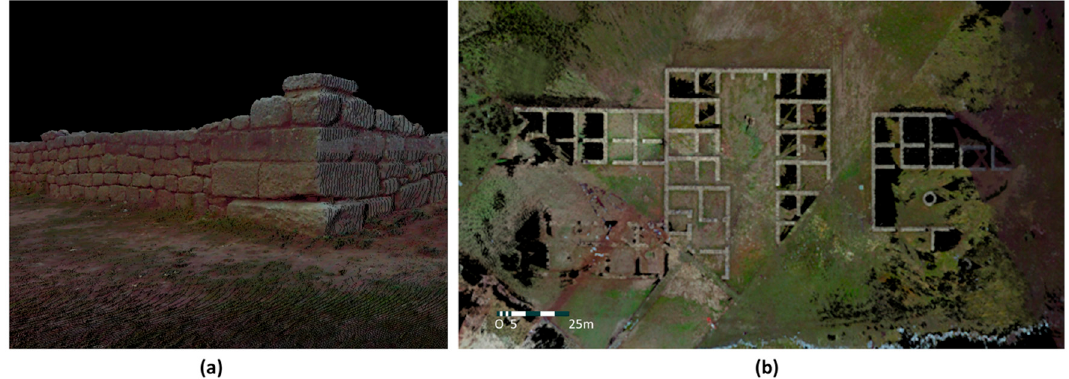
Figure 6. Results of the T-LiDAR survey: ( a ) Detailed view of a colored 3D point cloud of a stone wall and ( b ) orthoimage of the barrack in the Southern area of the Roman site